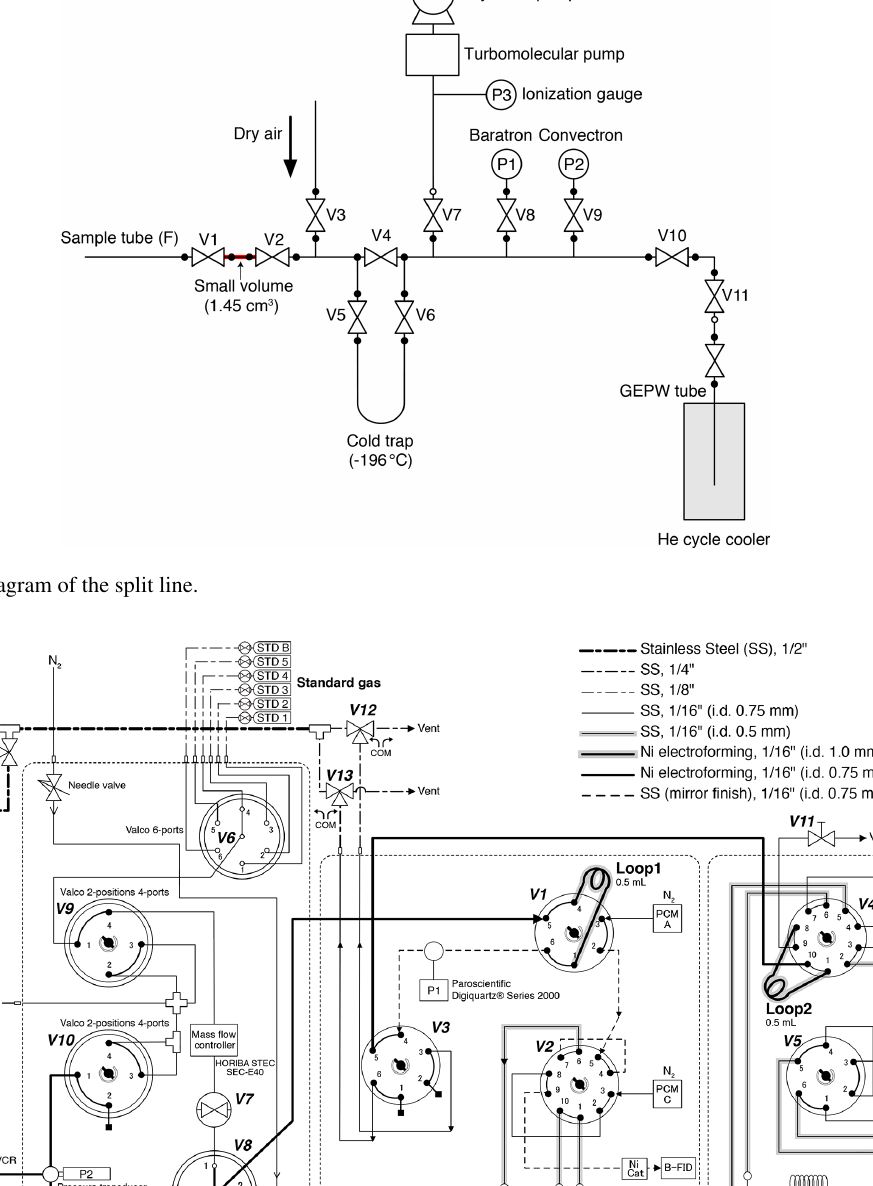
and makeup gases, and we use H 2 ( > 99.99995 %, Taiyo Nis- san Corp., Japan) for FID for GC1. Hydrocarbon-free air for FID is generated by a zero-air generator (PEAK Scien- tific, ZA015A). For GC2, we use He carrier ( > 99.99995 %, Taiyo Nissan Corp., Japan) for high separation, and we use the mixture of Ar and CH 4 (5 %) as makeup gas for high sen-